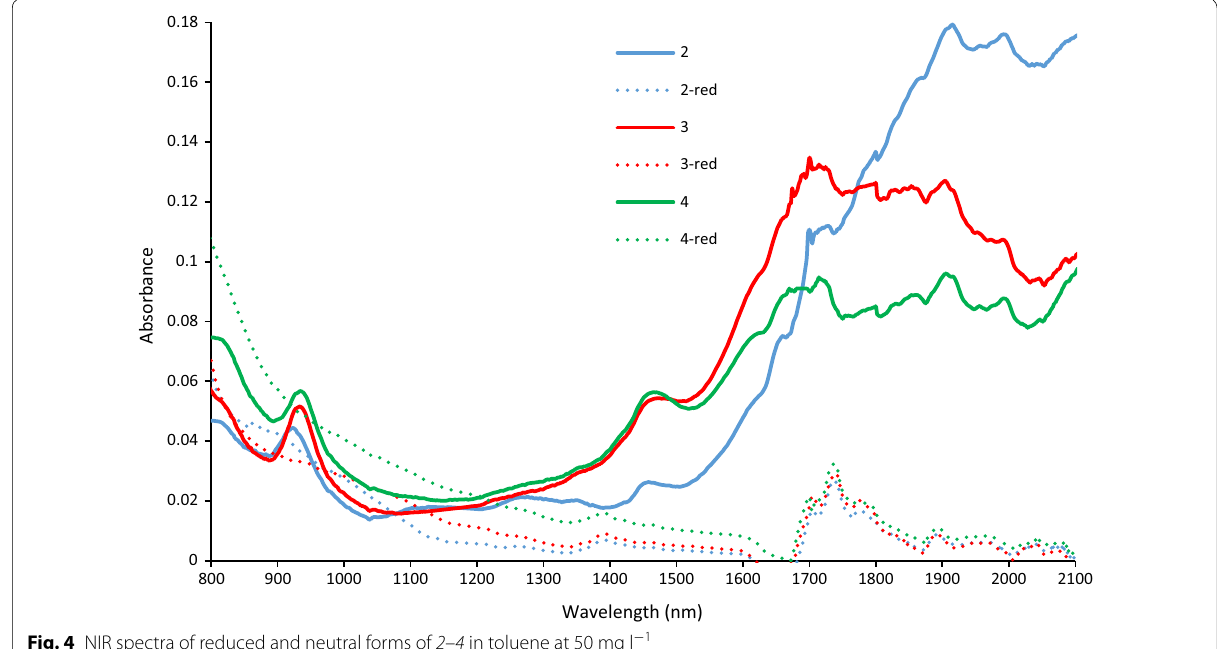
Fig. 4 NIR spectra of reduced and neutral forms of 2 – 4 in toluene at 50 mg l − 1